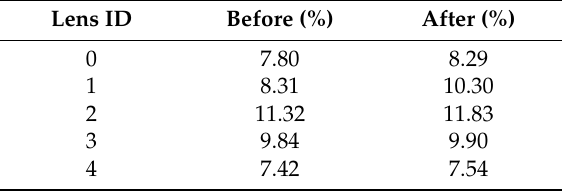
Figure 15. Definition of overlap rate: ( a ) image edge pixels; ( b ) LiDAR projected boundary points; ( c ) union of (a,b); ( d ) overlap of (a,b); ( e ) composition of (c) and highlighted (d). Table 4. Overlap rate based on the panoramic camera model before and after registration. Lens ID Before (%) After (%)